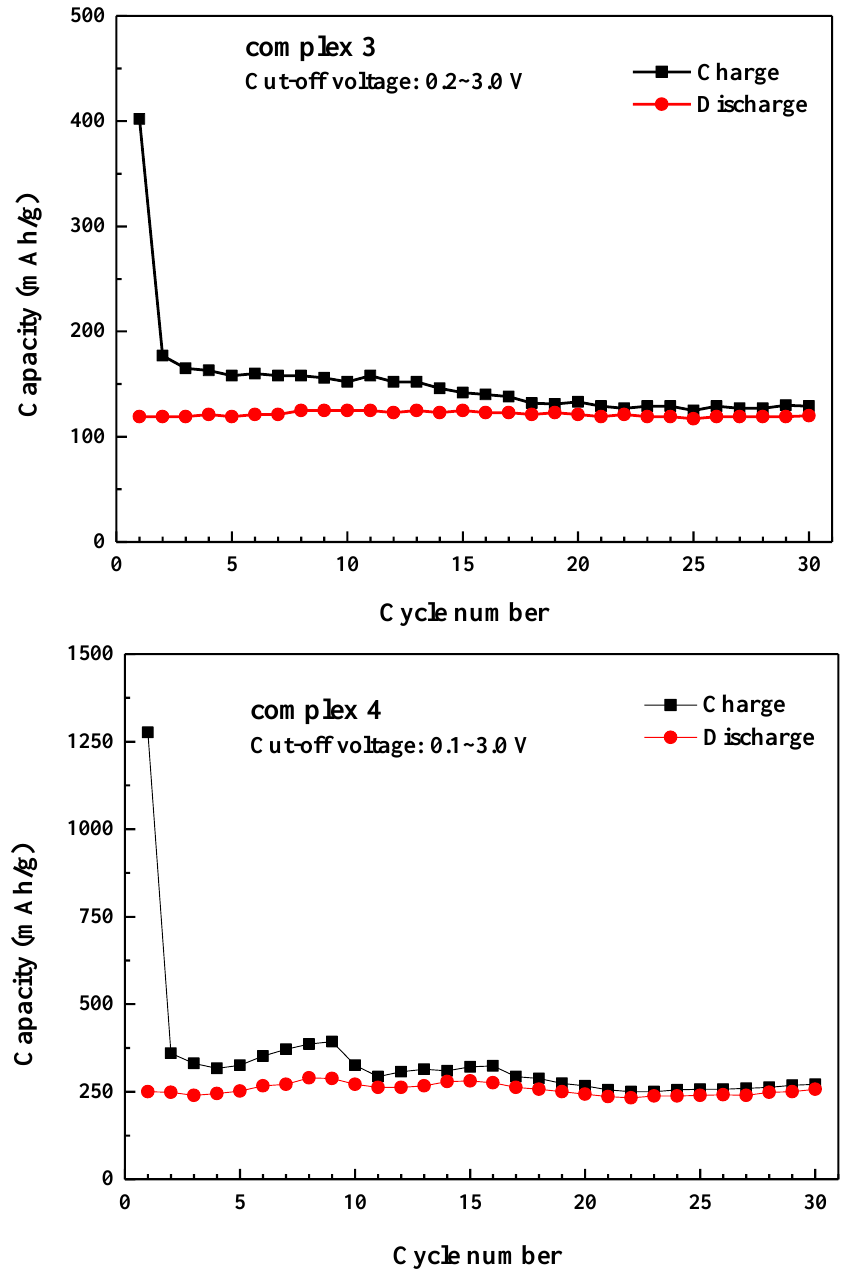
Figure 7. The Galvanostatic cycling of complexes 3 and 4 . Conditions: cycling rate, C/10; potential limits, 3.0 and 0.1 V; electrolyte, 1M LiPF 6 in EC:DMC (1:1 V / V ); 60% active material; 30% Super P; 10% PVDF binder.